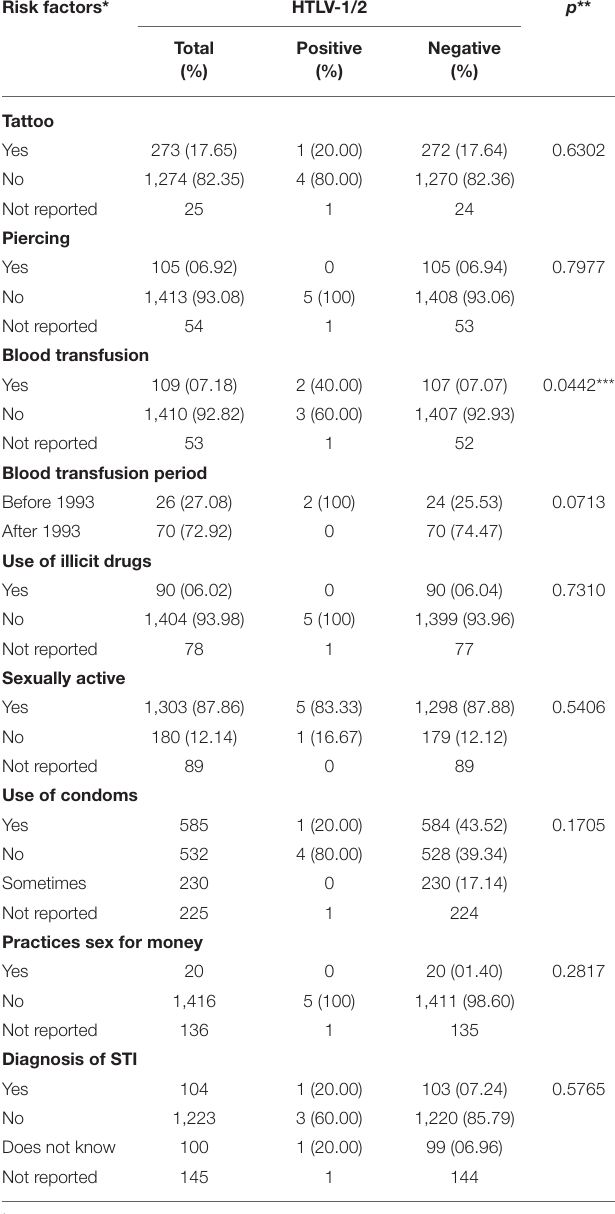
TABLE 3 | Risk factors associated with HTLV